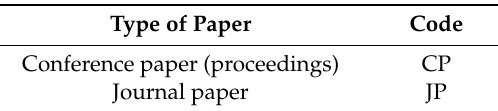
Table 4. Type of paper